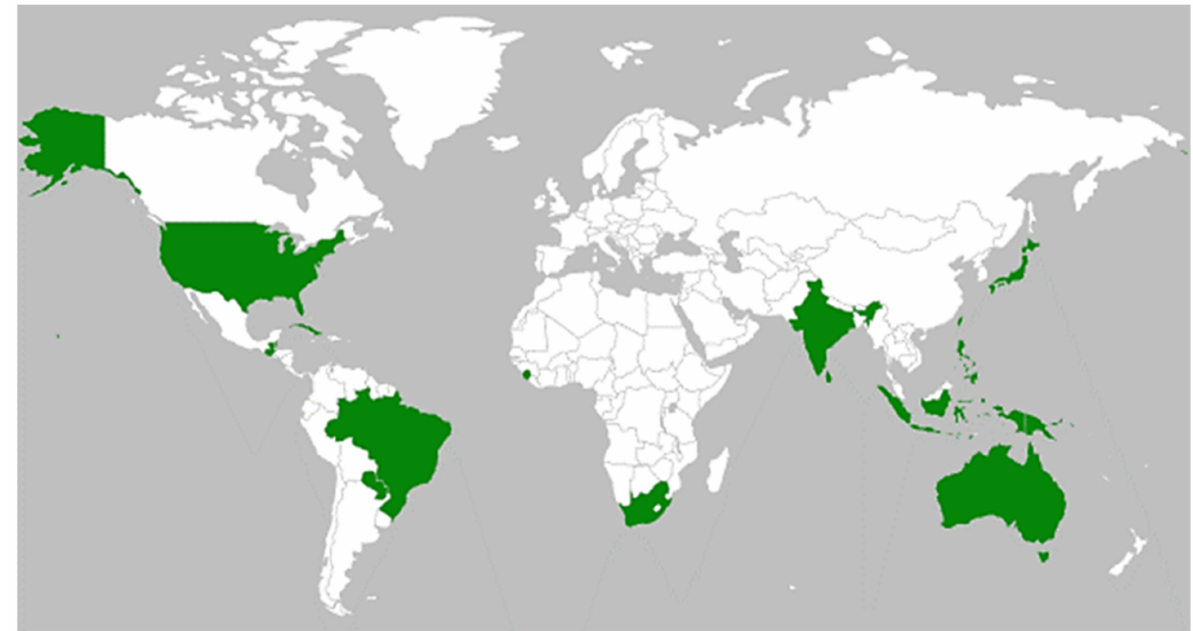
Figure 1. Map showing the global distribution of the described Skierka